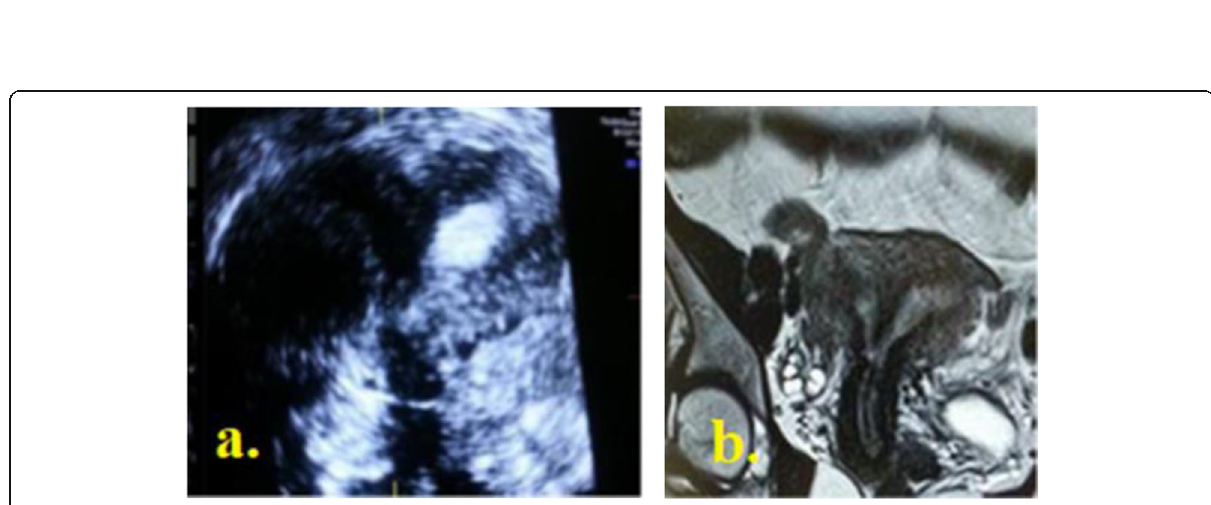
Fig. 9 A 28-year-old married female patient, complaining of infertility. a Bicorporeal septate uterus (class U3c) diagnosed by 3DTVS. It showed an external indentation at the fundal midline exceeding 50%of the uterine wall thickness and an internal indentation width exceeded 50% the uterine wall thickness. b MRI coronal oblique T2 showed straight fundal outline and complete septum. So, it was diagnosed by MRI as class U2b or complete septate uterus